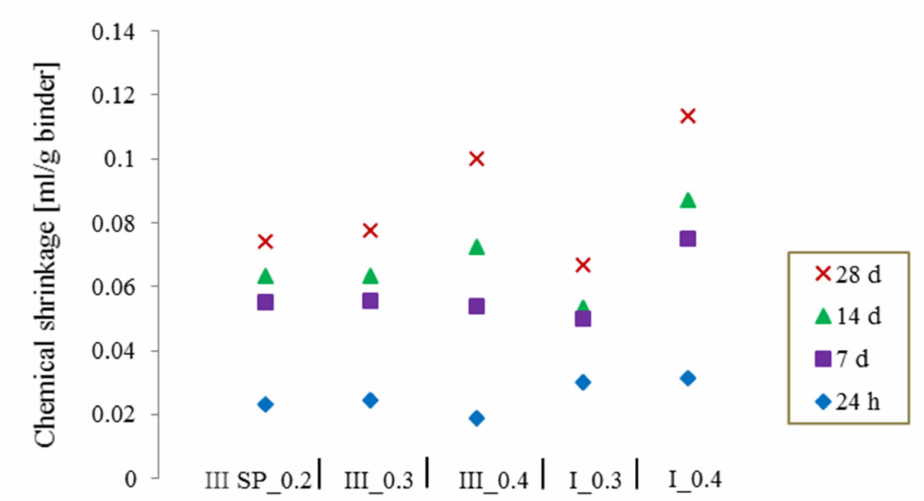
Figure 4. The increase of the chemical shrinkage over time for CEM I and CEM